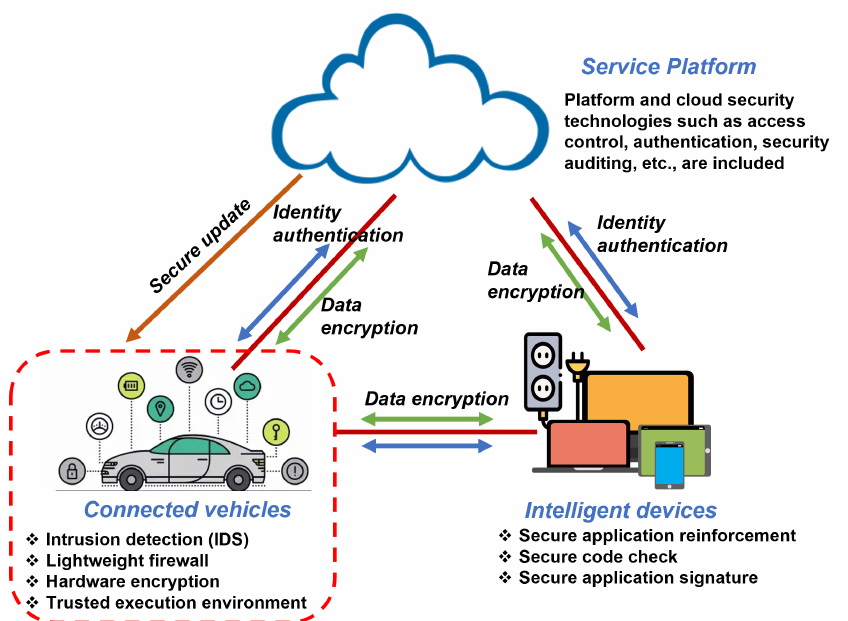
Figure 2. Various approaches to mitigating ICVs’ vulnerability to attacks highlighting the role of IDSs, among others